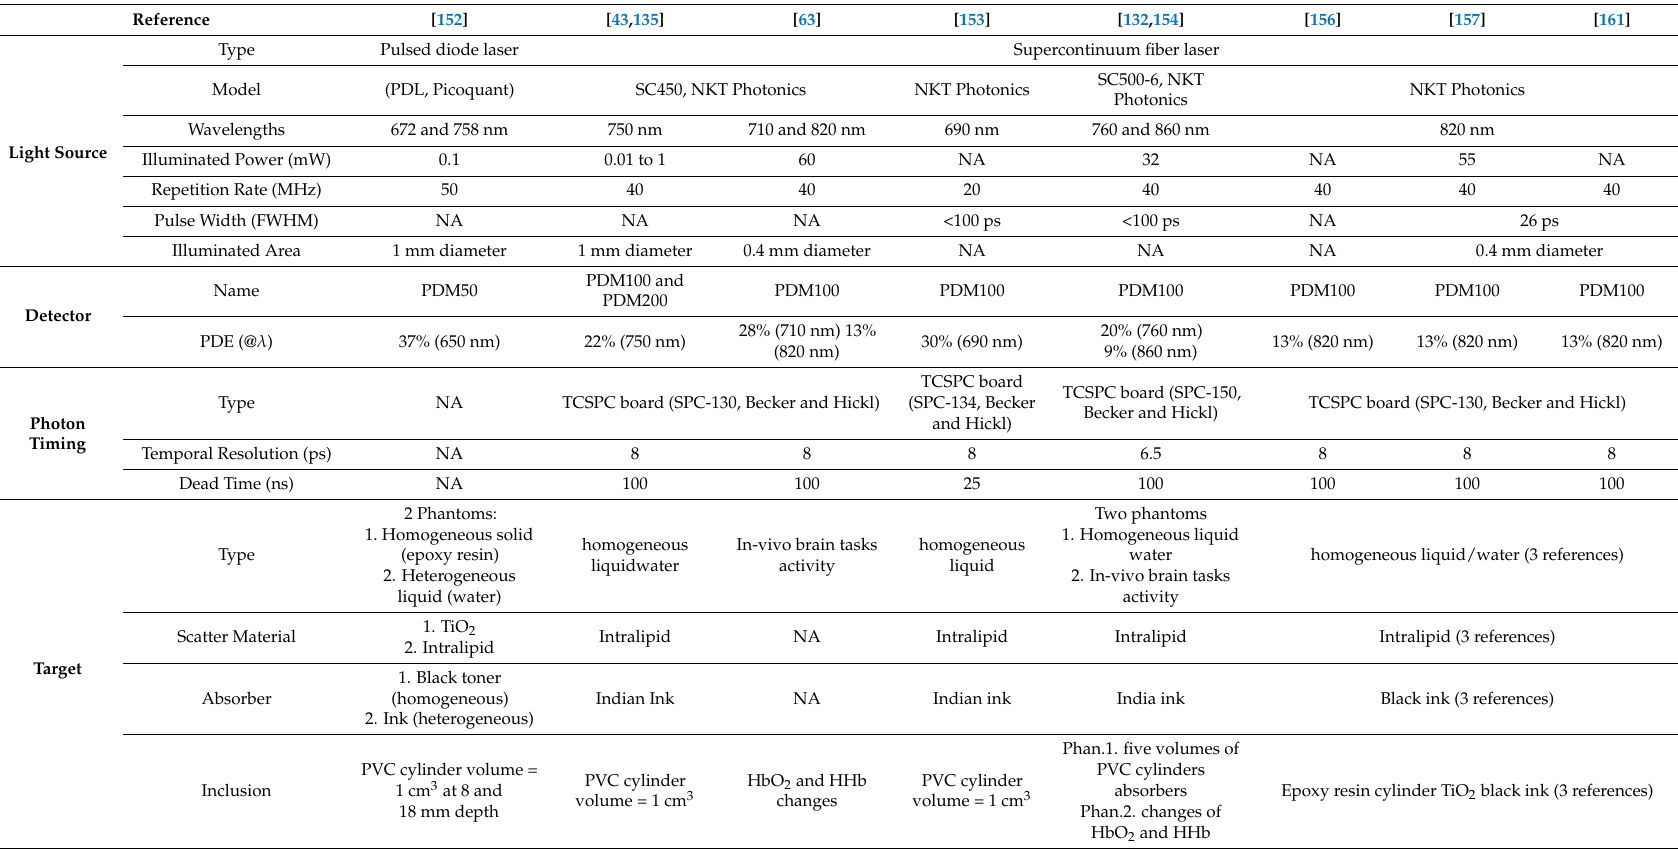
Table 3. Components, main features, and performance of TG TR-DOI